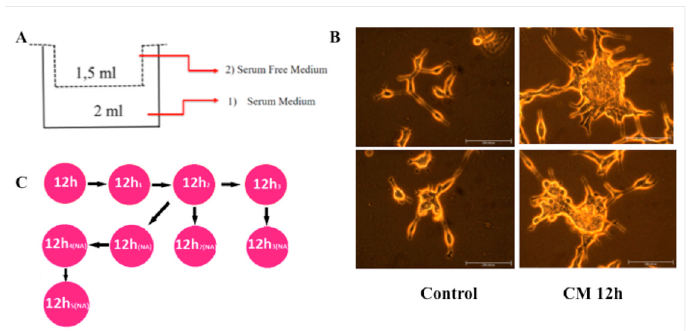
Figure 1. CM treatment induces migration in LNCaP cells. ( A ) The diagram for demonstrating migration assay with Transwell inserts. ( B ) CM treated and control cells incubated and cultured after migration for a month until enough number of cells were obtained for further experiments. Number of migrated cells after CM treatment was more than control (data not shown) group, but in the first month, possibly because of CM-induced-differentiation, proliferation rate of treated cells was lower then control cells. After this period CM treated cells have become more aggressive. ( C ) In the period of incubation, some cells observed to carry characteristics of suspension cell and these cells were separated and grown clonally. Each time when we passage these nonadhesive cells, some of them have become adhesive and others have maintained nonadhesive (NA) properties. Clones were named according to their adhesion properties.